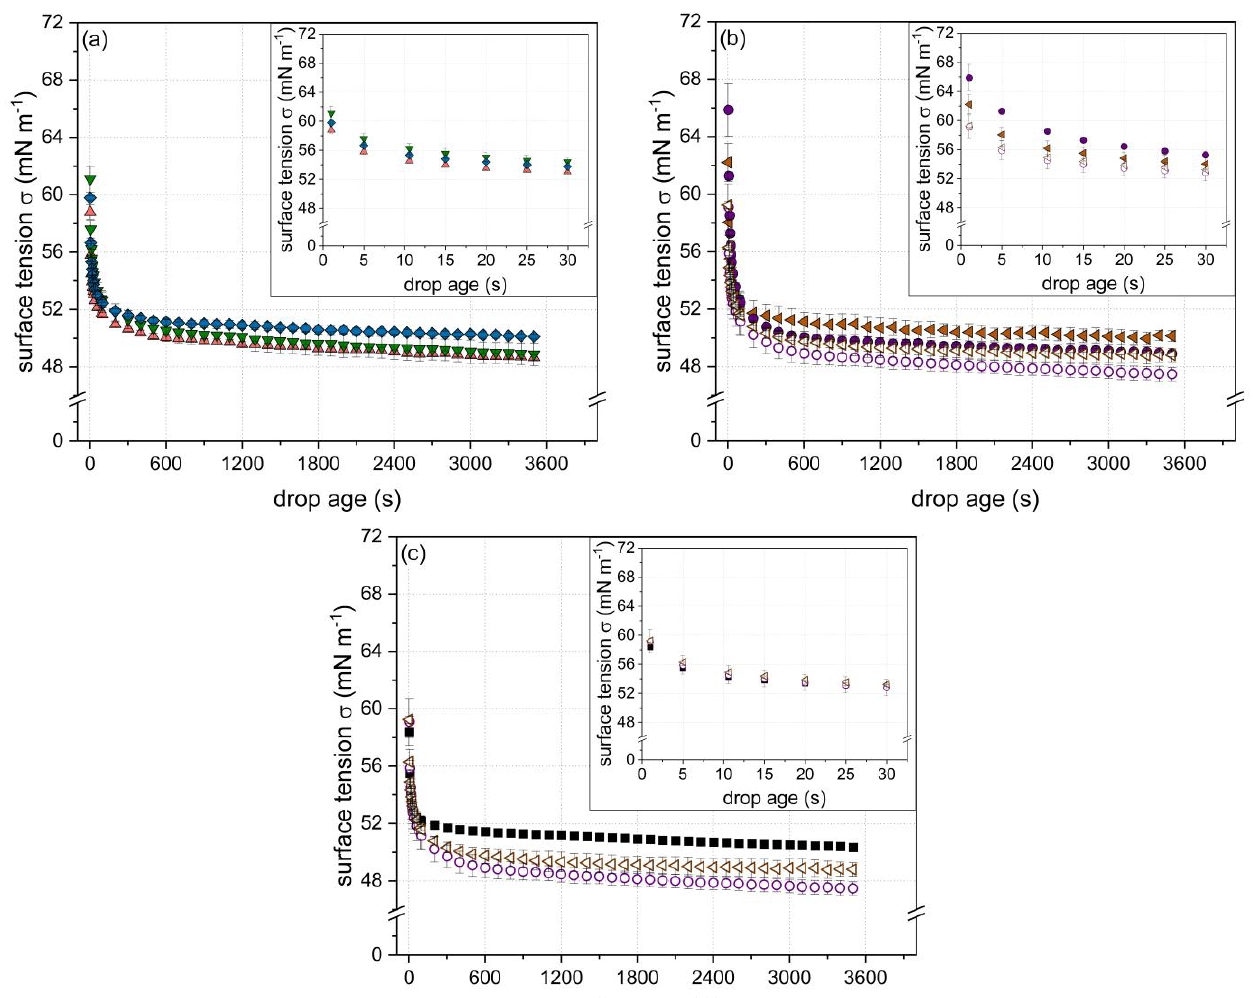
Figure 2. Evolution of surface tension ( σ ) in dependence of time as a function of the β -Lg particle (c = 8.2 g L − 1 ) physicochemical properties: ( a ) varying degree of cross-linking ( ▼ 85, ▲ 92, and ◆ 109%) but similar size (~22 nm) and similar zeta potential (~ − 30 mV); ( b ) varying net zeta potential ( ● -38 and ○ -30 mV or ◀ -35 and ◁ -29 mV, respectively) but similar size ( ● / ○ ~120 and ◀ / ◁ ~42 nm, respectively) and similar degree of cross-linking (~105%); ( c ) varying particle size ( ■ 3, ◁ 40, and ○ 119 nm) and degree of cross-linking ( ■ 120 and ◁ / ○ ~105%) but a similar zeta potential of ~-30 mV. Error bars indicate standard deviation.